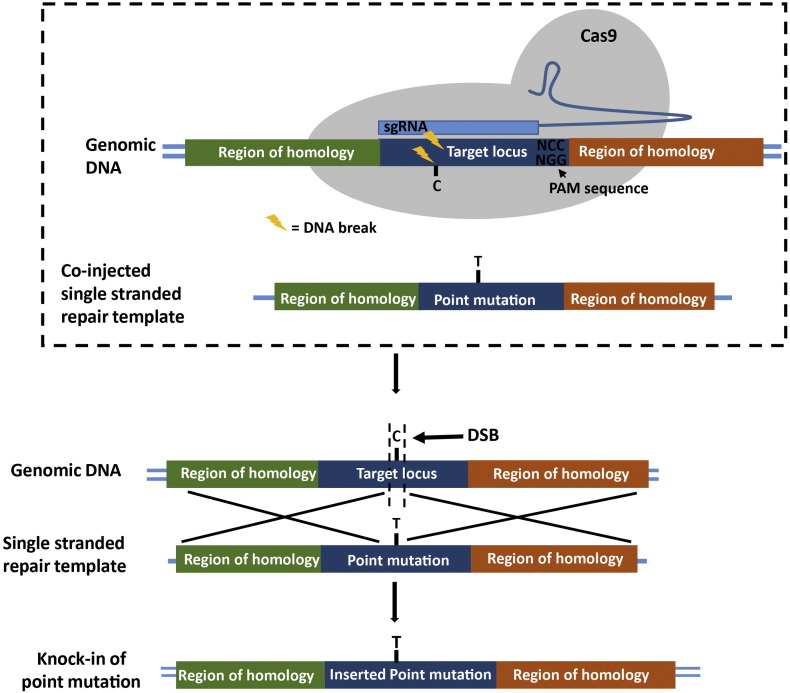
The introduction of a point mutation. A single stranded repair template is co-injected with the sgRNA and the Cas9 mRNA. This single stranded oligonucleotide contains a point mutation flanked by homology arms (indicated by green and orange regions of homology) to elicit homology directed repair. After Cas9 produces a double strand break (DSB), homology directed repair follows, with the insertion of the point mutation into the genomic DNA target region. In this example, a C to T point mutation is produced and demonstrates how different alleles of a SNP can be studied using CRISPR.